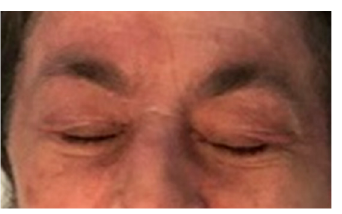
Figure 2. Close-up view of palpebral heliotropic erythema.